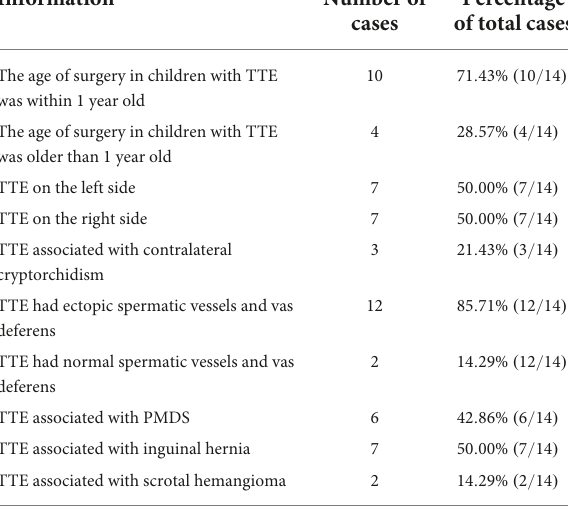
TABLE 1 Demographics of 14 cases of transverse testicular ectopia in children.